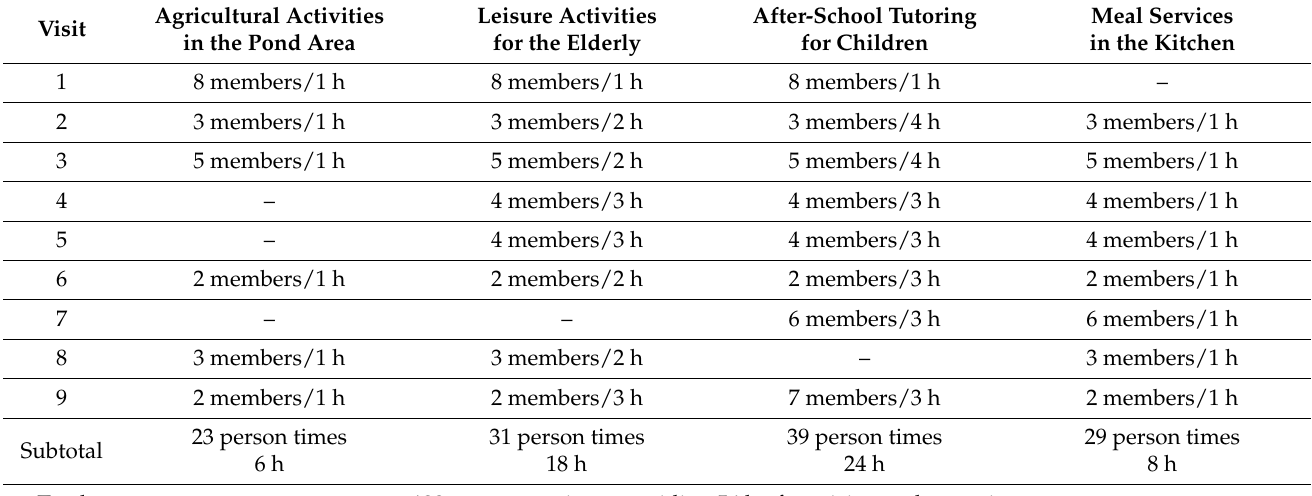
Table 2. Details of participant